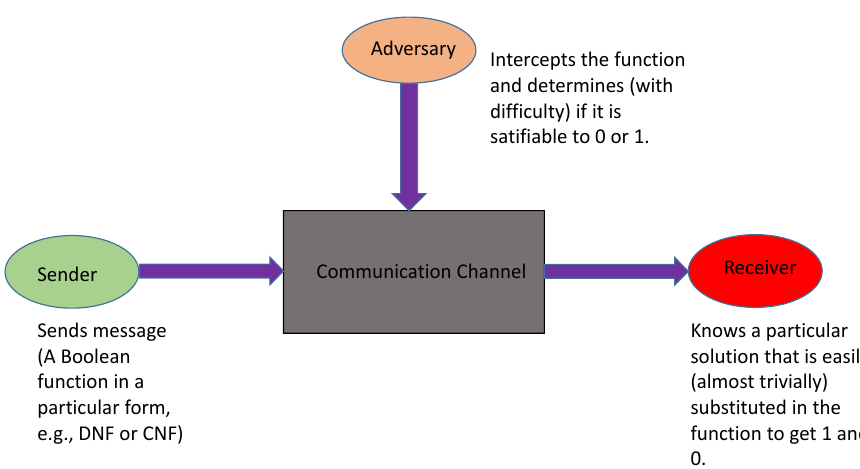
Fig. 1. Roles of the sender, receiver and adversary in an insecure communication channel with SAT employed as a